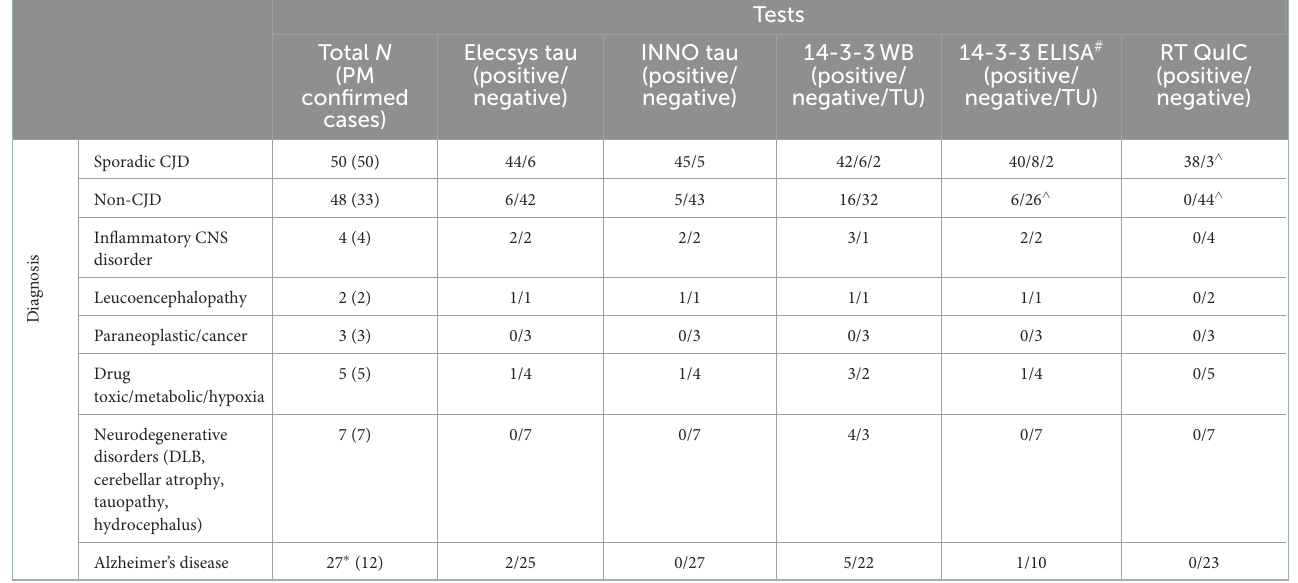
TABLE 2 Patient cohorts and results for each CSF biomarker assayed.